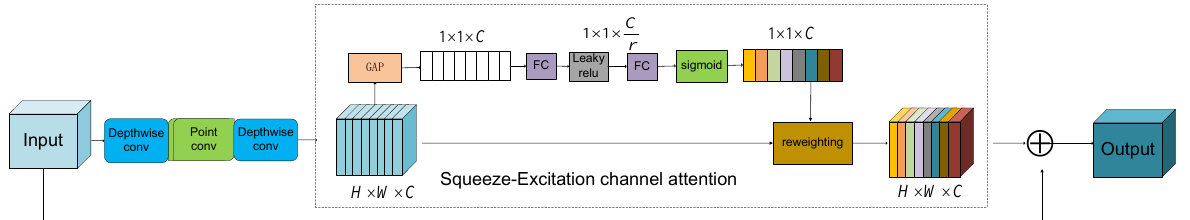
Figure 3. Sandglass-Residual module based on the Squeeze-Excitation channel attention.